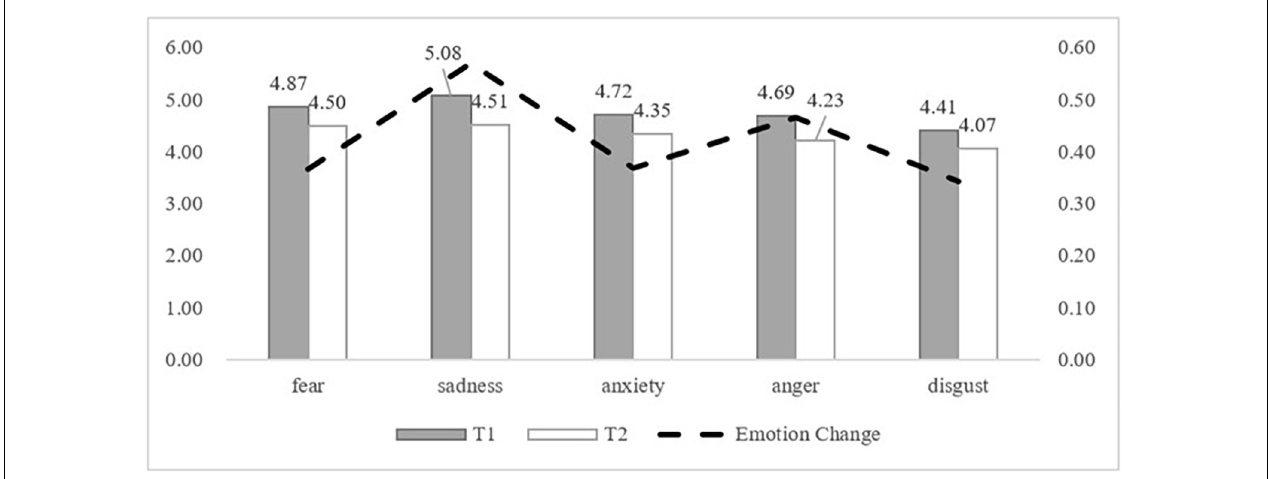
FIGURE 1 | Emotional strength between T1 and T2.